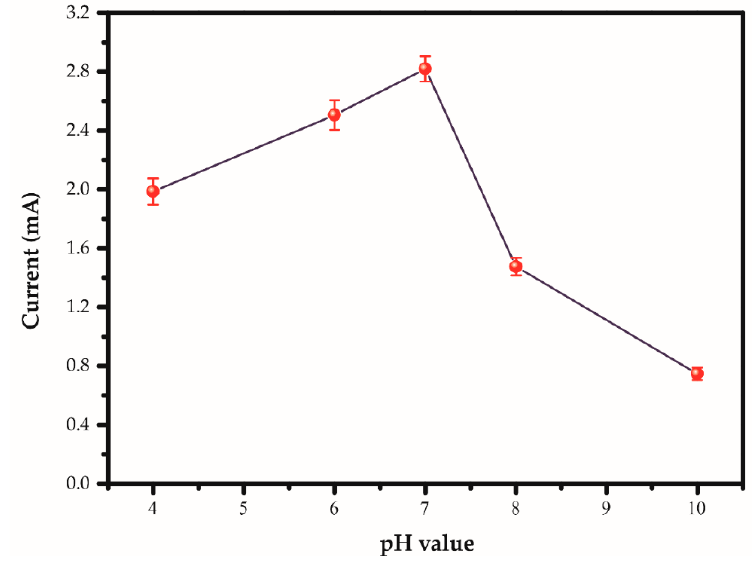
Figure 7. Anodic peak currents of AgNPs/GO/SPE sensor in 100 mM sodium concentration in 0.1 M TRIS at the different pH at a scan rate of 100 mV s − 1 .